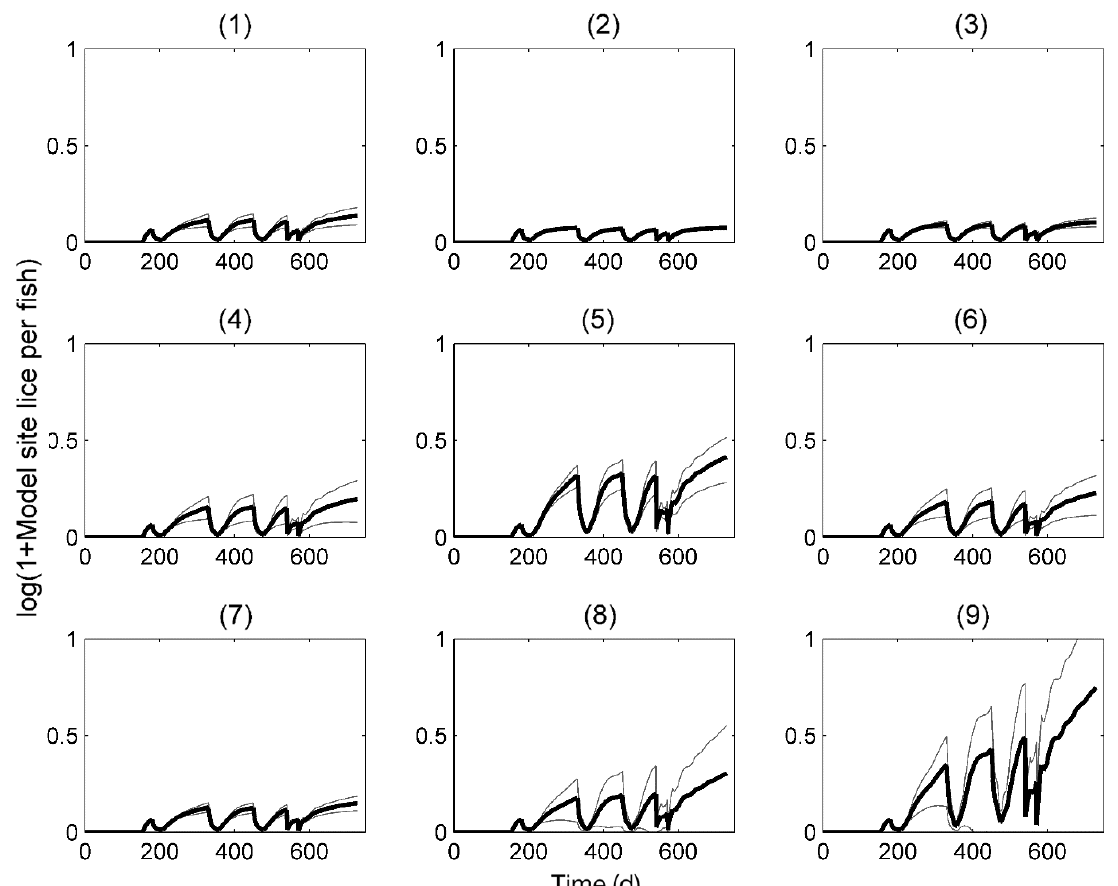
Fig. 6. Lice density at each model site over the duration of the production cycle, when all sites were managed according to the schedule presented in ‘Methods: Management treatments’ (each site receives constant external lice infection of 0.01 lice fish −1 d −1 and reproduction of 5 lice adult female −1 d −1 ; same parameters as Fig. 3)